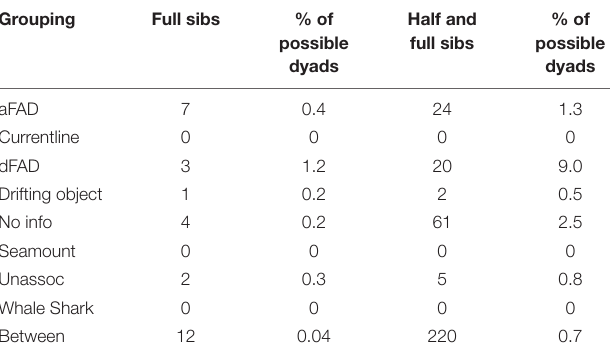
TABLE 6 | The distribution of kin, organized by type of associated